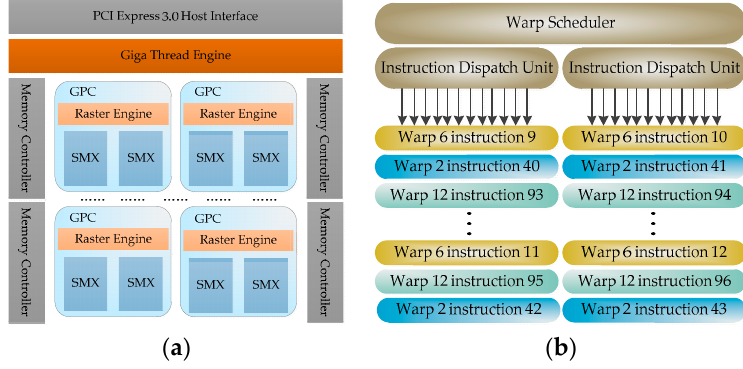
Figure 4. GeForce GTX 680 main architecture: ( a ) Block diagram; ( b ) A single warp scheduler.